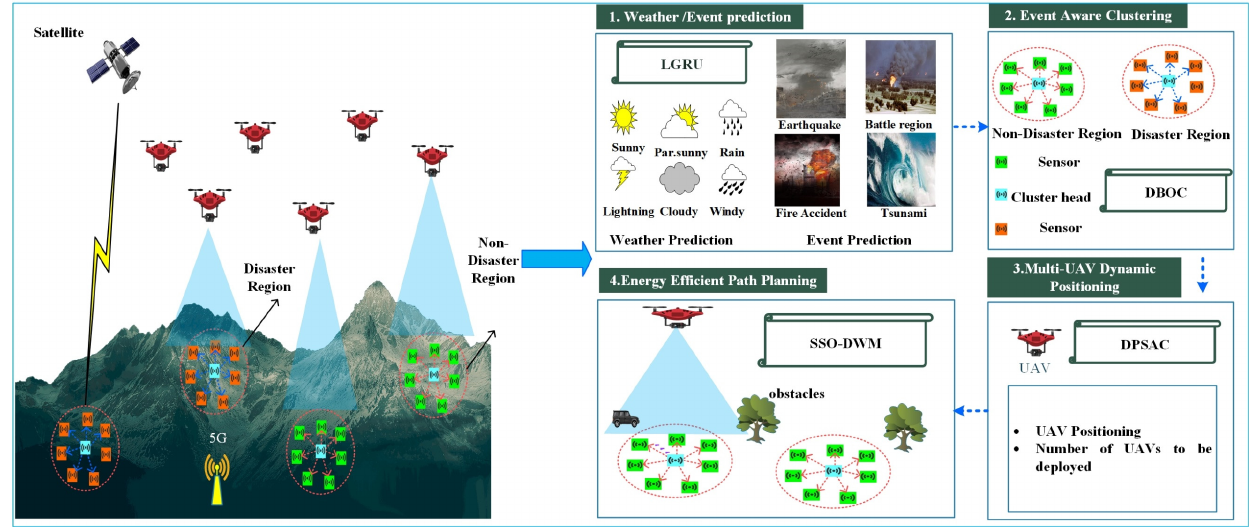
Figure 3. The overall architecture of the dynamic UAV approach.